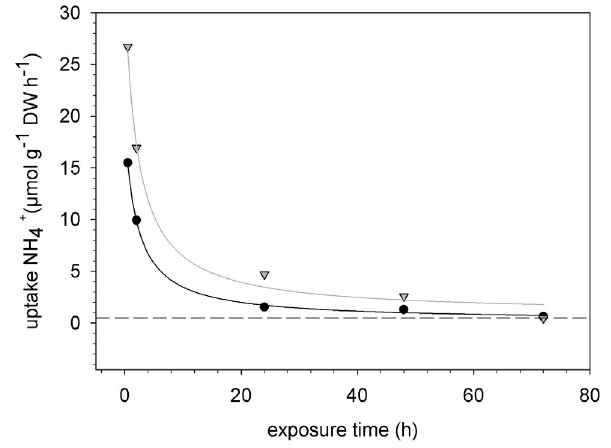
Figure 3. Decrease in ammonium uptake at the pristine site with increasing exposure time on. Eq. 2 fitted well (r 2 =0.99) for the uptake data for both 10 m M (black circles) and 100 m M (grey triangles). The half-time value ‘b’ was 2.1 hours for both concentrations. The constant (C) was lower in the 10 m M treatment (0.22 m mol N gDW 2 1 h 2 1 ) compared to the 100 m M treatment (0.88 m mol N gDW 2 1 h 2 1 ). Dashed line indicates critical N-uptake to maintain biomass production (0.8 m mol N gDW 2 1 h 2 1 ). Note that uptake rates at 24 hours and later were based on the depletion of ammonium in the experimental solution, whereas other rates presented in this paper are average rates calculated from 15 N uptake.